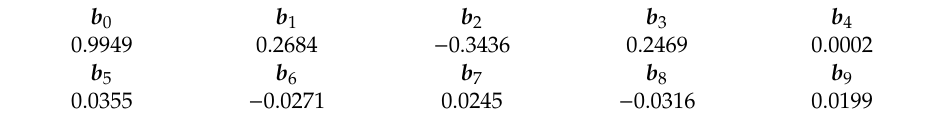
Table 4. Estimated coe ffi cients for f 1 using the train data and the RSM model.